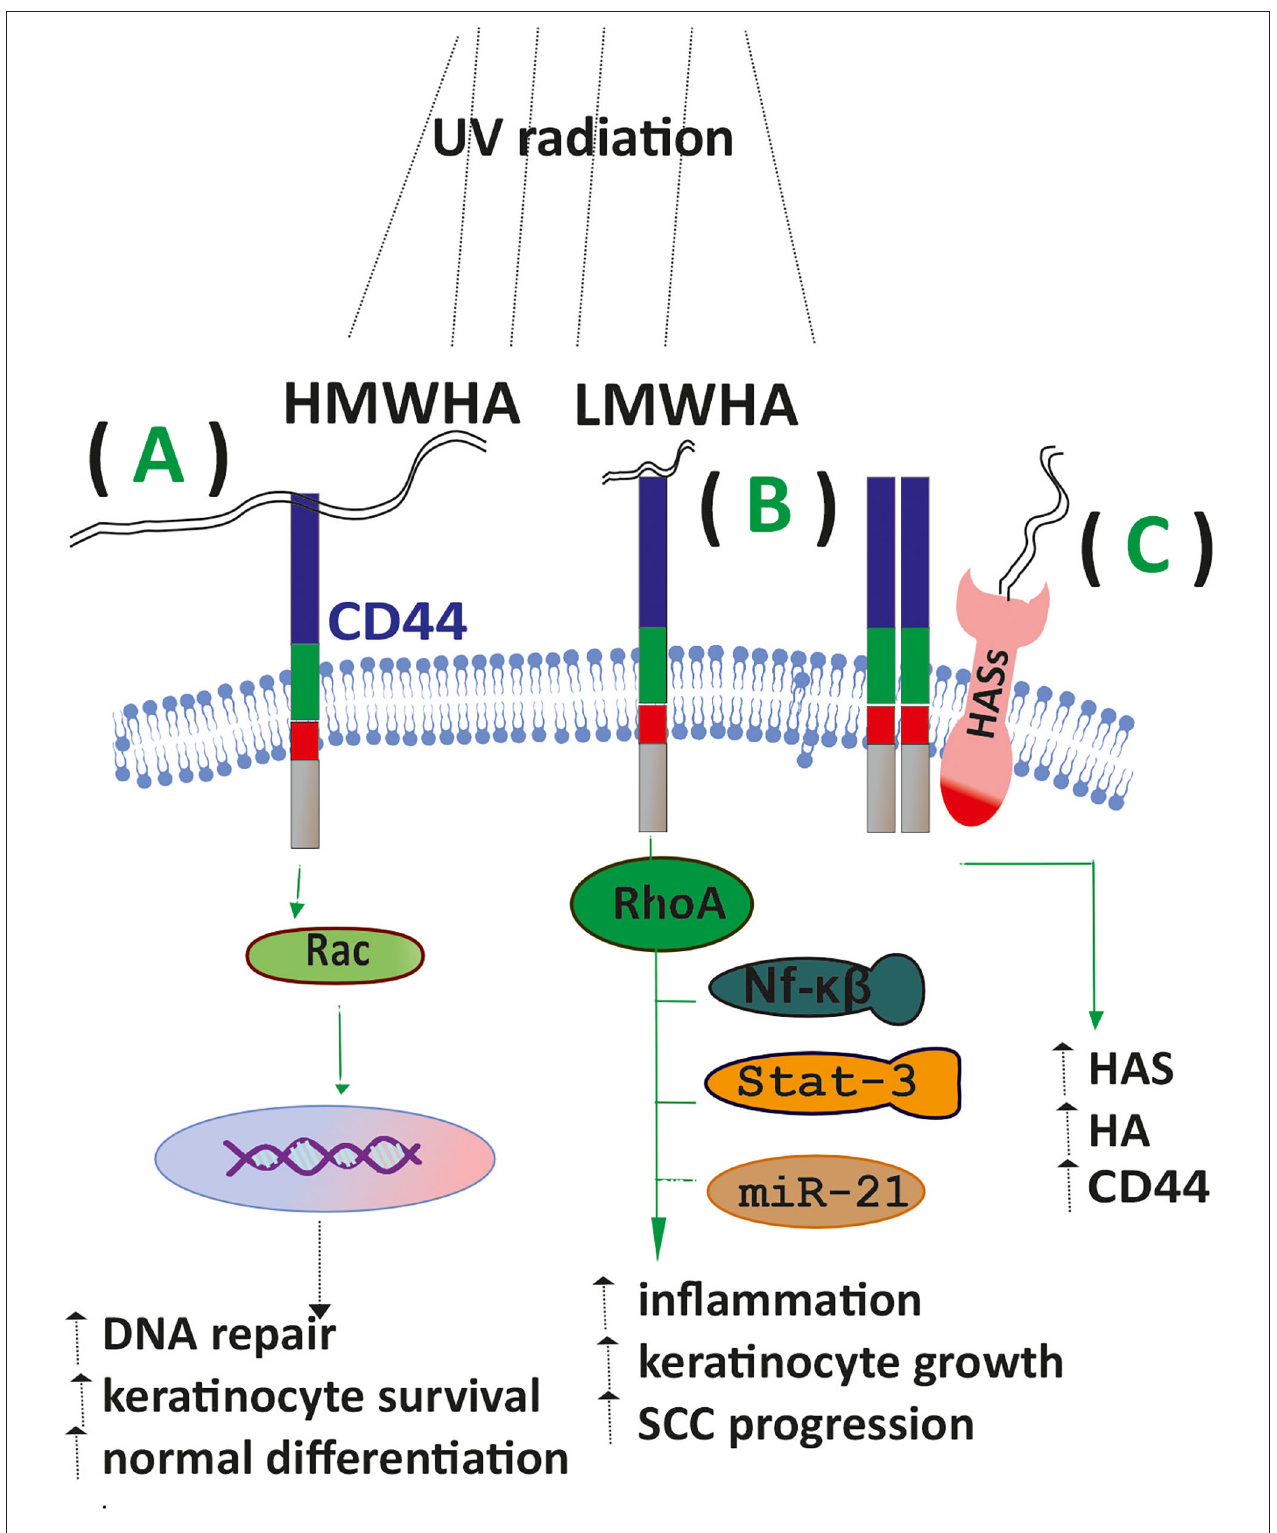
FIGURE 2 | HA signaling affects SCC progression. (A) Upon exposure of keratinocytes to UV radiation, the binding of HMWHA to the CD44 receptor enhances DNA repair, keratinocyte survival, and normal differentiation. (B) LMWHA/CD44 binding in exposed keratinocytes promotes the inflammatory response, keratinocyte proliferation, and SCC progression. (C) Exposed keratinocytes show increased expression of HAS enzymes CD44 and increased HA deposition.